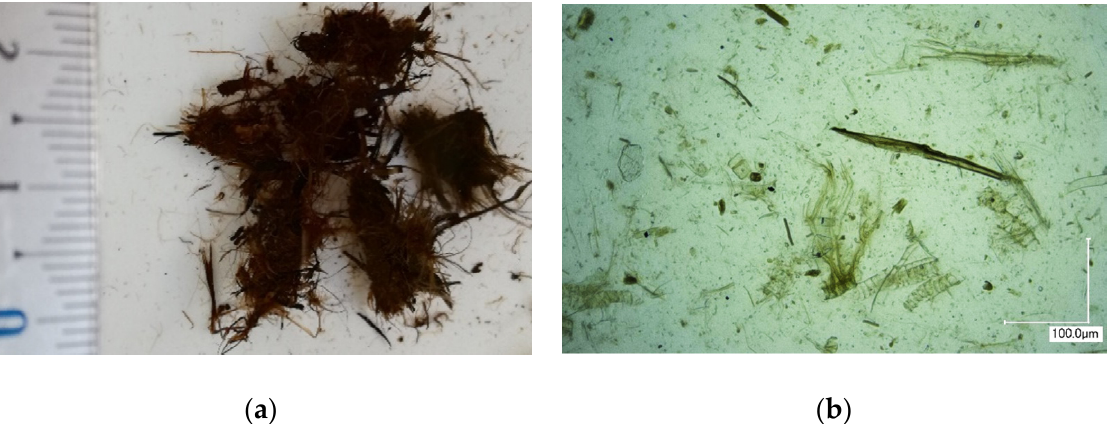
Figure 2. Peat agglomerates ( a ) before and peat particles ( b ) after treatment by high-speed multidisc mixer–disperser (HSMD).